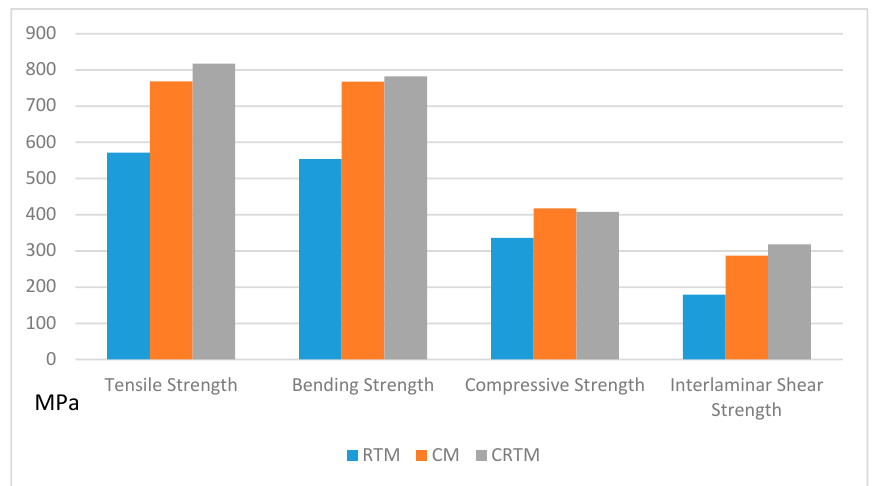
Figure 10. Mechanical properties of samples prepared by CM, RTM, and CRTM.